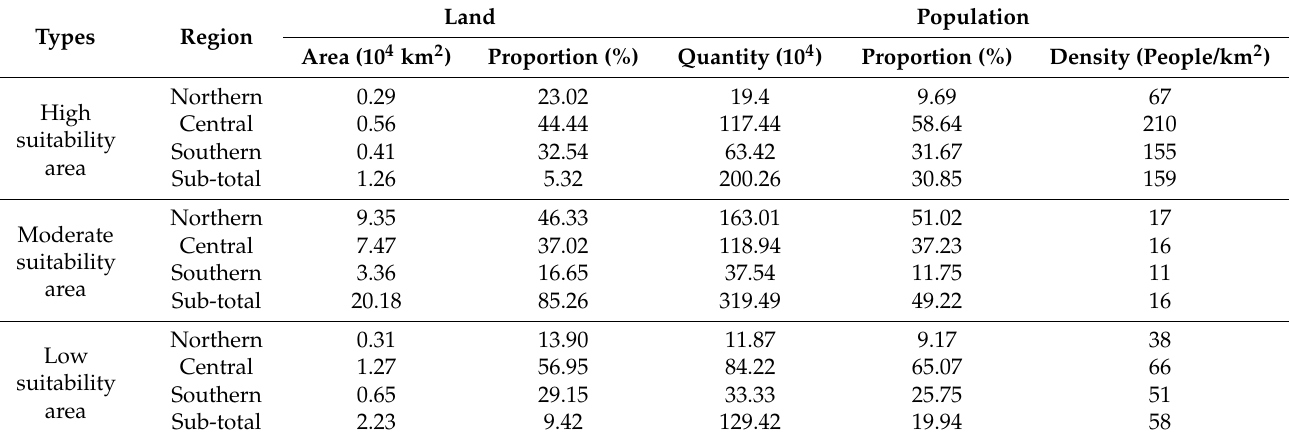
Table 2. Results of the natural suitability assessment of human settlements using the HSI in